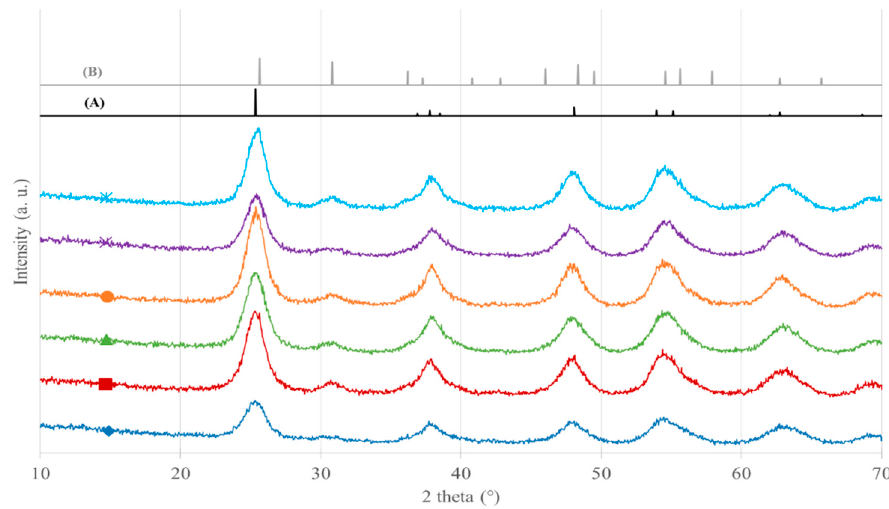
Figure 1. X-ray diffraction (XRD) patterns: ( ♦ ) pure TiO 2 , ( ■ ) TiO 2 /Zr2.8, ( ▲ ) TiO 2 /U4, ( ● ) TiO 2 /U4/Zr2.8, ( × ) TiO 2 /N42, (*) TiO 2 /N42/Zr2.8. ( A ) Reference pattern of anatase and ( B ) reference pattern of brookite. Table 1. Quantitative analysis of samples’ crystallinity and dopant content by